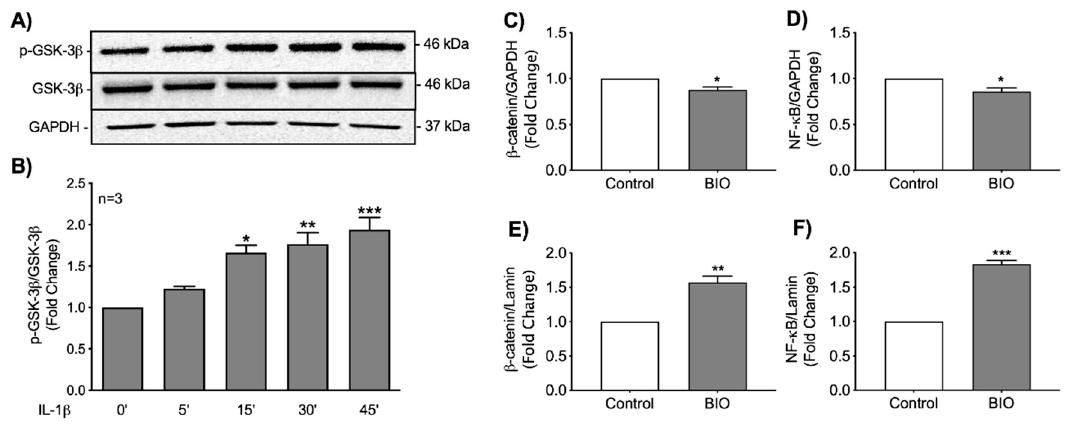
Figure 6. IL-1 β -associated GSK-3 β phosphorylation and nuclear import of β -catenin and NF- κ B in BIO-treated human astrocytes. Primary human astrocytes were treated with IL-1 β (20 ng / mL) for 0, 5, 15, 30, and 45 min. Total cell lysates were collected and probed for ( A ) phosphorylated (p)-GSK-3 β , total GSK-3 β and GAPDH. ( B ) Densitometry analysis was used to calculate the p-GSK-3 β to GSK-3 β ratio at each timepoint. GAPDH was used as a loading control. Statistical analyses were performed using one-way ANOVA with Tukey’s post-hoc test for multiple comparisons. Data represent average fold change ± SEM from four individual astrocyte donors (* p < 0.05, ** p < 0.01, *** p < 0.001). Human astrocytes were treated with 6-bromoindirubin-3 ′ -oxime (BIO) (500 nM, dark grey bars) or without (Control, white bars). Cytosolic and nuclear fractions of cell lysates were collected 24 h post treatment, ( C , E ) β -catenin and ( D , F ) NF- κ B levels were determined by the WES capillary protein detection system by using specific antibodies. GAPDH and lamin were used as loading controls for cytosol and nuclear fractions, respectively. Data represent average fold change ± SEM from three individual astrocyte donors. Statistical analyses were performed using student’s t -test (* p < 0.05, ** p < 0.01, *** p < 0.001).